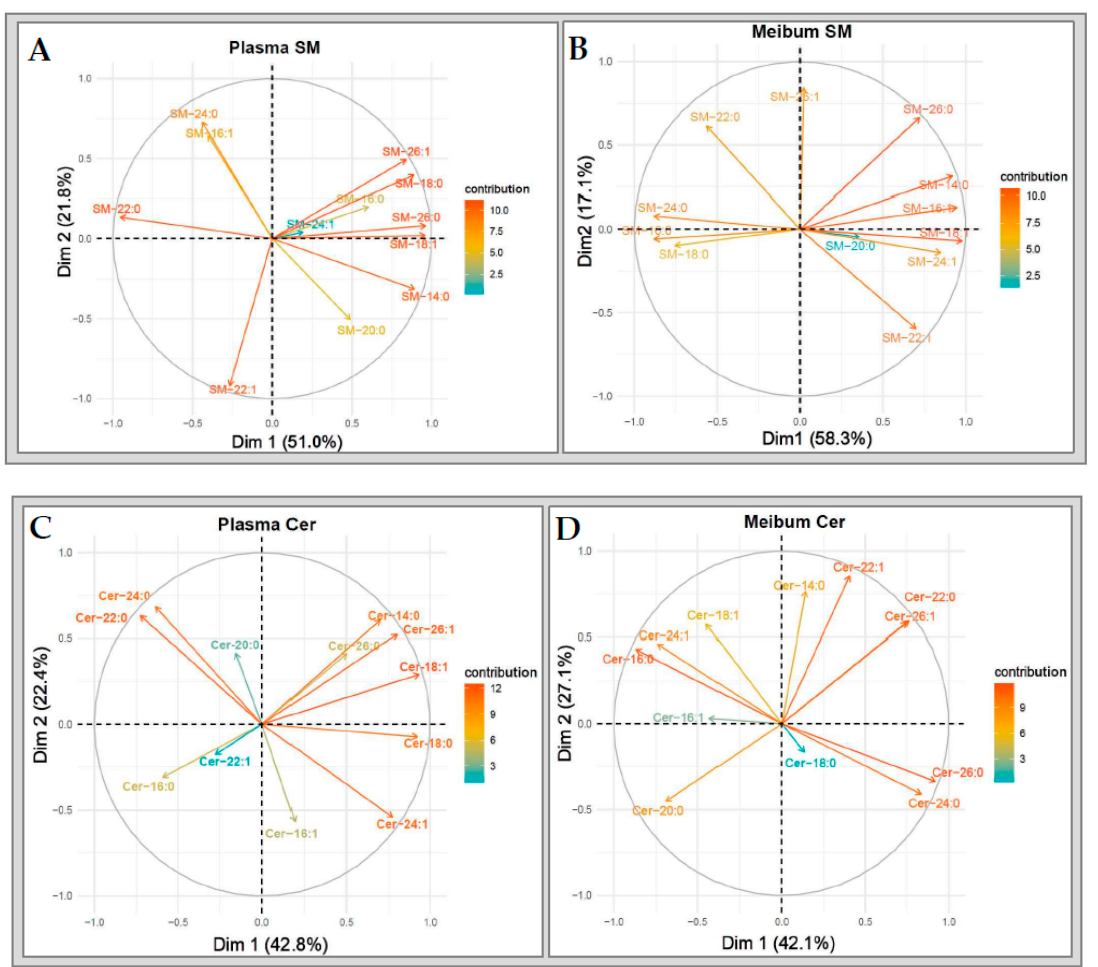
Figure 10. Variable correlation plots of ( A ) plasma SM and ( B ) meibum SM species. Variable correlation plots of plasma ( C ) Cer and ( D ) meibum Cer species.